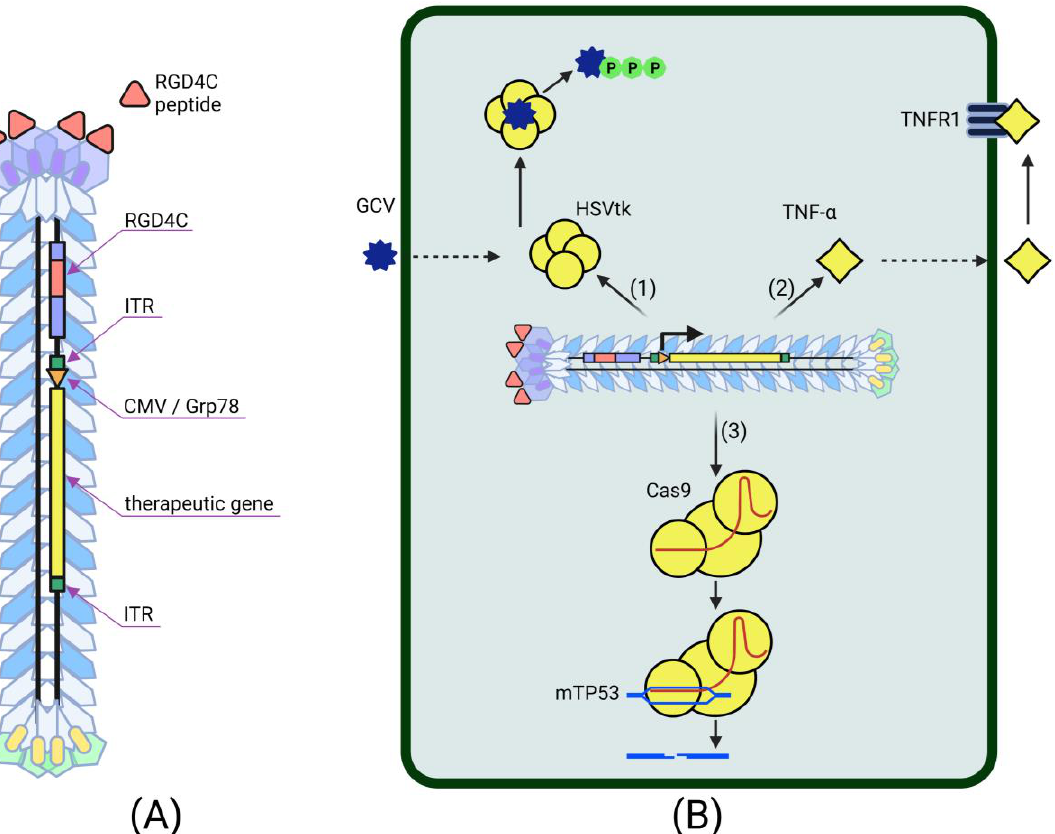
Figure 2. ( A ) Structure of RGD4C-targeted AAV/phage (AAVP) hybrid virus. The chimeric virus displays several copies of the RGD4C peptide on its pIII proteins to serve as a targeting ligand which specifically binds to β3 integrin receptors. The AAVP contains a therapeutic gene expression cassette flanked by AAV inverted terminal repeats (ITRs) and includes the CMV or Grp78 promoter; ( B ) Cancer gene therapy using the AAVP vector. (1) Suicide gene therapy mediated by the transformation of ganciclovir (GCV) to the toxic metabolite GCV-triphosphate under the influence of the herpes simplex virus thymidine kinase (HSVtk) expressed by AAVP in target cancer cells. (2) The delivery and expression of tumor necrosis factor α (TNF - α) by the AAVP in cancer cells leads to the release of this multifunctional protein and its binding to cell-surface receptors. The interaction of TNF- α with tumor necrosis factor receptor 1 (TNFR1) leads to the activation of various apoptotic pathways and cancer cell death, mediating cytokine gene therapy. (3) The goal of p53 gene replacement therapy is to disable the defective mutant tumor suppressor p53 gene (mTP53) and to simultaneously introduce the native functional p53 gene. Disabling the mTP53 can be mediated by combining the AAVP vector with clustered regularly interspaced short palindromic repeat/CRISPR-associated protein 9 (CRISPR/Cas9) technology, targeting the desired nucleotide sequence and generating DNA double-strand